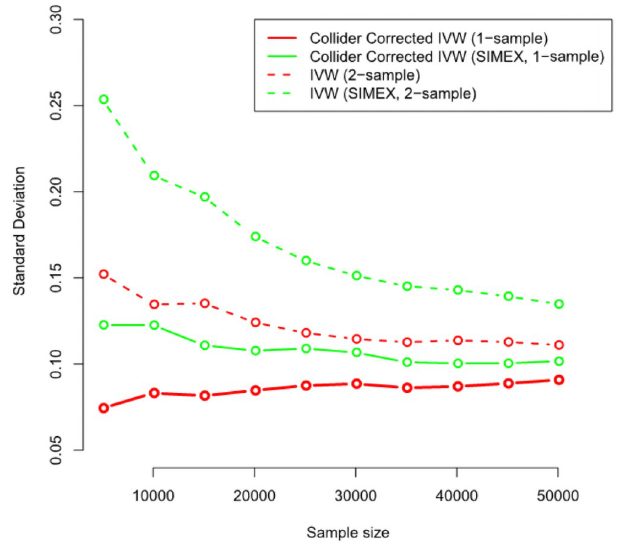
Fig 7. A comparison of the one sample Collider-Correction versus two-sample IVW approaches in terms of efficiency.